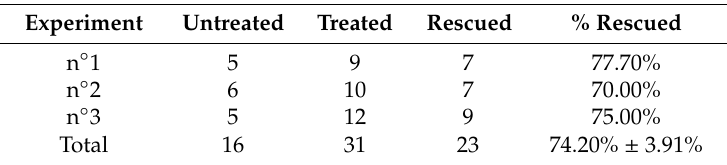
Table 1. The table shows data obtained in three treatments with ceftriaxone 1.0 mM, comparing the total number of treated embryos (“treated”) with the rescued ones (“rescued”) versus the untreated (“untreated”). The rescued are expressed as a percentage (“% rescue”). Percentages of mean value and standard deviation are shown at the bottom of the